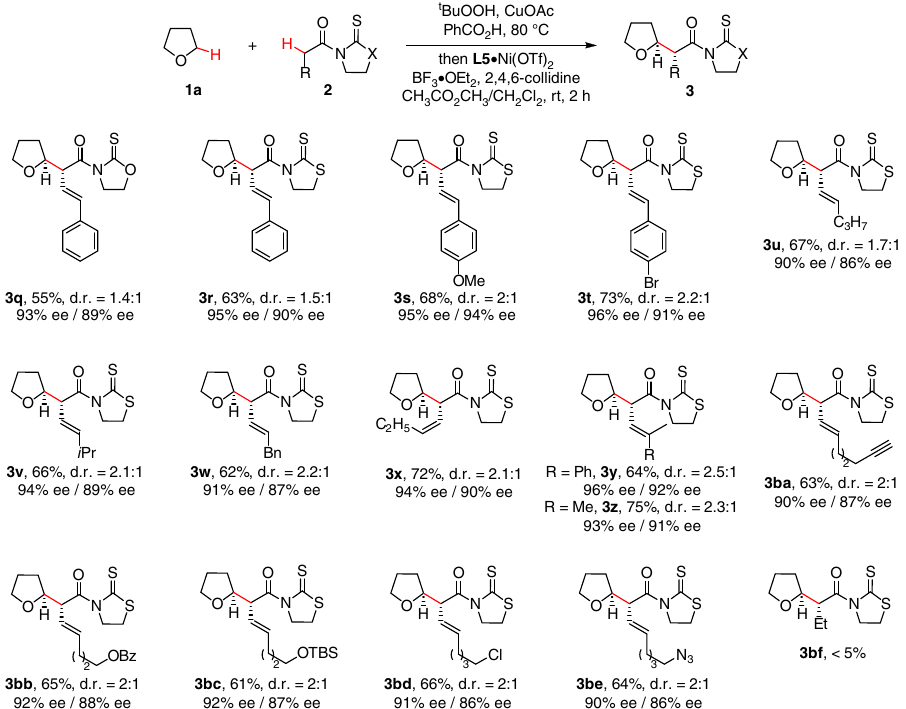
Fig. 2 The scope of α -alkenyl acetic acid derivatives. Conditions: PhCOOH (0.5 mmol, 2.5 equiv), CuOAc (2.5 mol%), t BuOOH in decane (2.5 equiv) in THF (1.0 mL) at 80 °C for 2 h, followed by 2 (1.0 equiv), L5·Ni(OTf) 2 (10 mol%), 2,4,6-collidine (3.0 equiv), and BF 3 ·OEt 2 (4.0 equiv) in CH 3 CO 2 CH 3 /CH 2 Cl 2 (0.3 mL/0.1 mL) at rt for 2 h